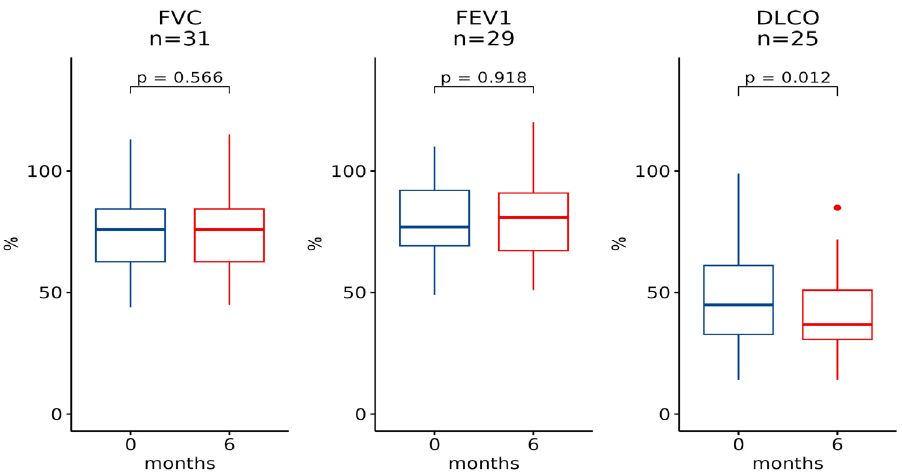
Figure 1. The 6 ‐ month trend for spirometry measurements. Box ‐ plots representing levels of FVC, FEV1 and DLCO at baseline and after 6 months. FEV1 and DLCO at baseline and after 6 months. Table 2. Steroid use in responders and non ‐ responders for FVC and DLCO.